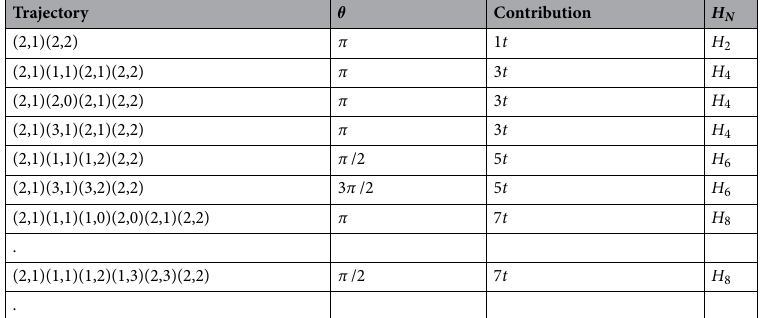
t α → β . For this simplified example, we set αβ (cid:31)